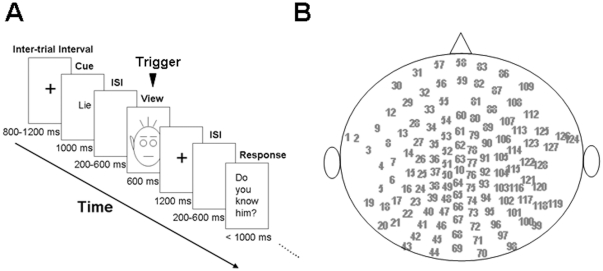
Task paradigm and 2D map of channels.(A) Schematic paradigm of the directed-lying task. In each trial, after a randomized inter-trial interval of 800 to 1,200 ms, a condition cue of either “Lie” or “Truth” was presented on the screen for 1,000 ms. This was followed by a randomized 200 to 600 ms blank screen inter-stimulus interval (ISI), after which a face appeared on the screen for 600 ms. A fixation cross was presented on the screen for 1,200 ms to allow time for the participants to prepare their response. Finally, after a randomized 200 to 600 ms blank ISI, the question “Do you know him?” appeared on the screen to prompt a response. Participants were asked to respond within 1,000 ms in accordance with the lie/truth cue presented previously. (B) 2D map of the channels distributed on the scalp. The top denotes the frontal side and the left denotes the left side.